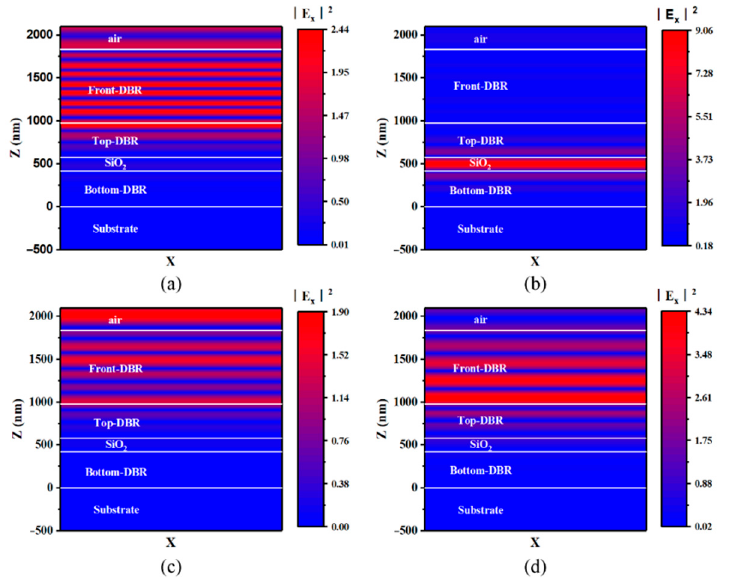
Figure 9. Distribution of electric field in filter at 460 nm ( a ), 520 nm ( b ), 600 nm ( c ), and 700 nm ( d ). The thickness of SiO 2 interlayer in FP cavity is 170 nm.